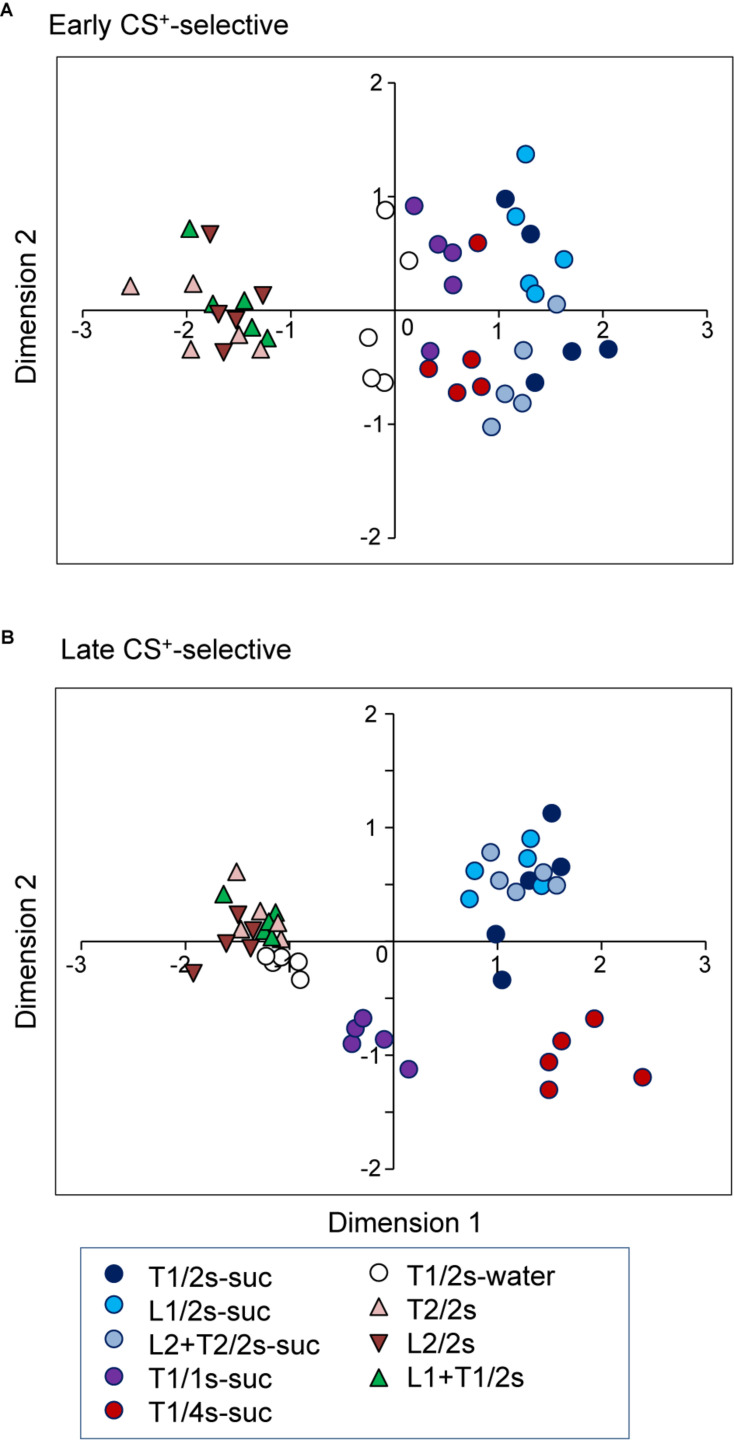
Distributions of the nine CSs in two-dimensional space resulting from multidimensional scaling (MDS) of the activities of the 20 early CS+-selective neurons (A) and the 20 late CS+-selective neurons (B). In (A) three clusters were recognized (multiple discriminant analysis, p < 0.0001 for all analyses), while five clusters were recognized in (B) (multiple discriminant analysis, p < 0.0001). T1/2s-suc, 2-s Tone1 associated with sucrose; L1/2s-suc, 2-s Light1 associated with sucrose; L2 + T2/2s-suc, 2-s Light2 + Tone2 associated with sucrose; T1/1s-suc, 1-s Tone1 associated with sucrose; T1/4s-suc, 4-s Tone1 associated with sucrose; T1/2s-water, 2-s Tone1 associated with water; T2/2s, 2-s Tone2 associated with non-reward; L2/2s, 2-s Light2 associated with non-reward; L1 + T1/2s, 2-s Light1 + Tone1 associated with non-reward.